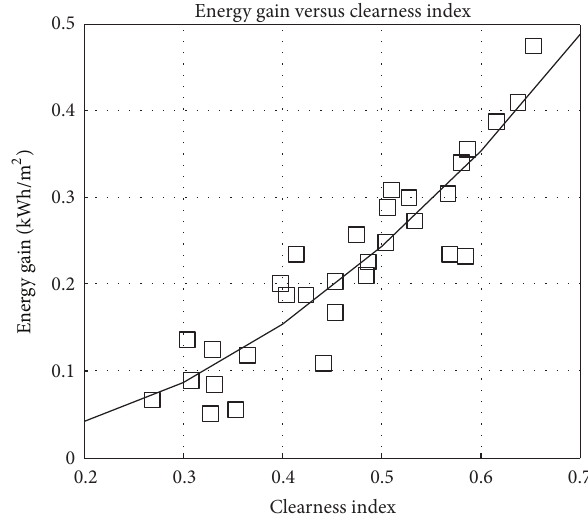
Figure 13: Efficiency of DAST over SSS versus daily clearness index. Figure 14: Energy gain of DAST over SSS versus daily clearness